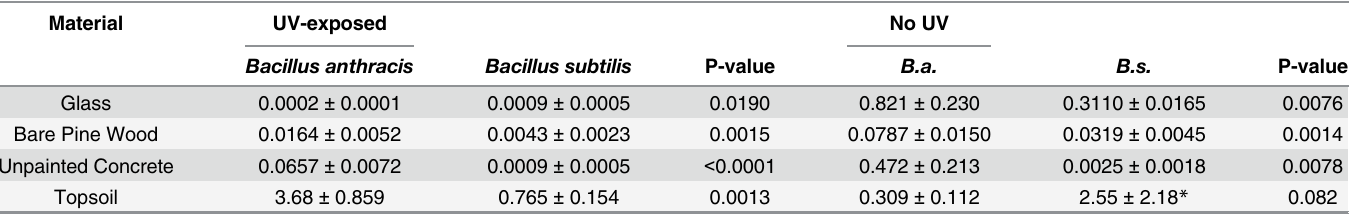
Table 2. Initial recovery of B . anthracis and B . subtilis spores (Average N 2 /N 0 ±